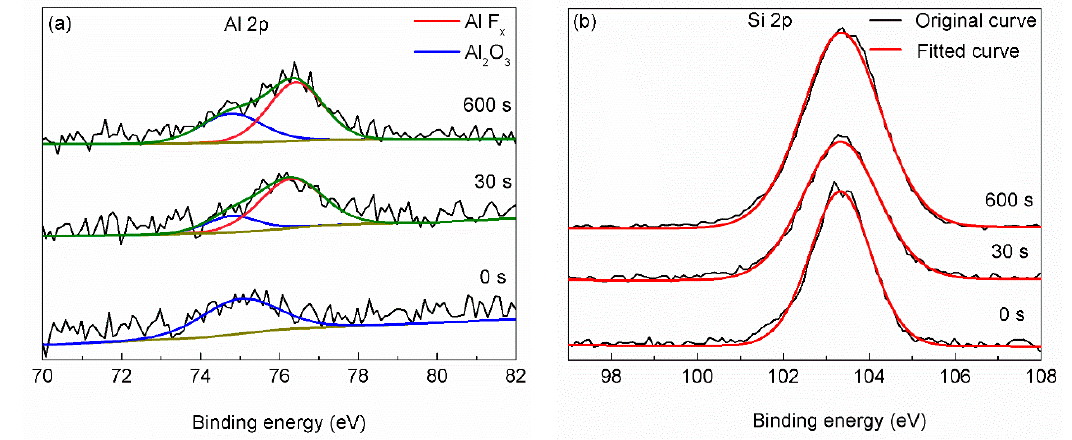
Figure 8. Al 2p ( a ) and Si 2p ( b ) narrow scanning curves obtained before etching and after 30 s and 600 s etching.